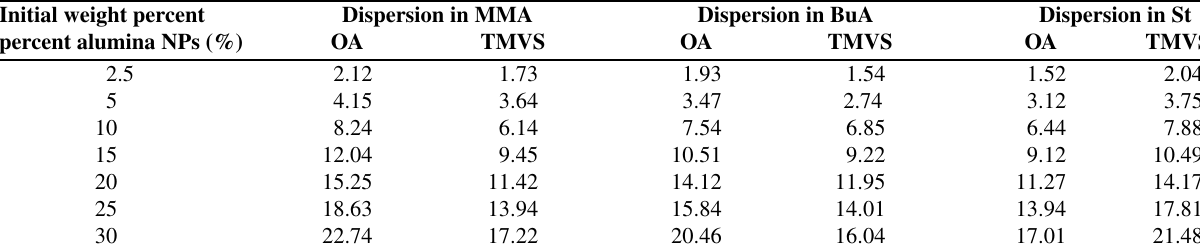
Table 2: Dispersion of alumina NPs modified with oleic acid (OA) and trimethoxy-vinylsilan (TMVS) in some organic media (%). Initial weight percent Dispersion in MMA Dispersion in BuA Dispersion in St percent alumina NPs (%) OA TMVS OA TMVS OA